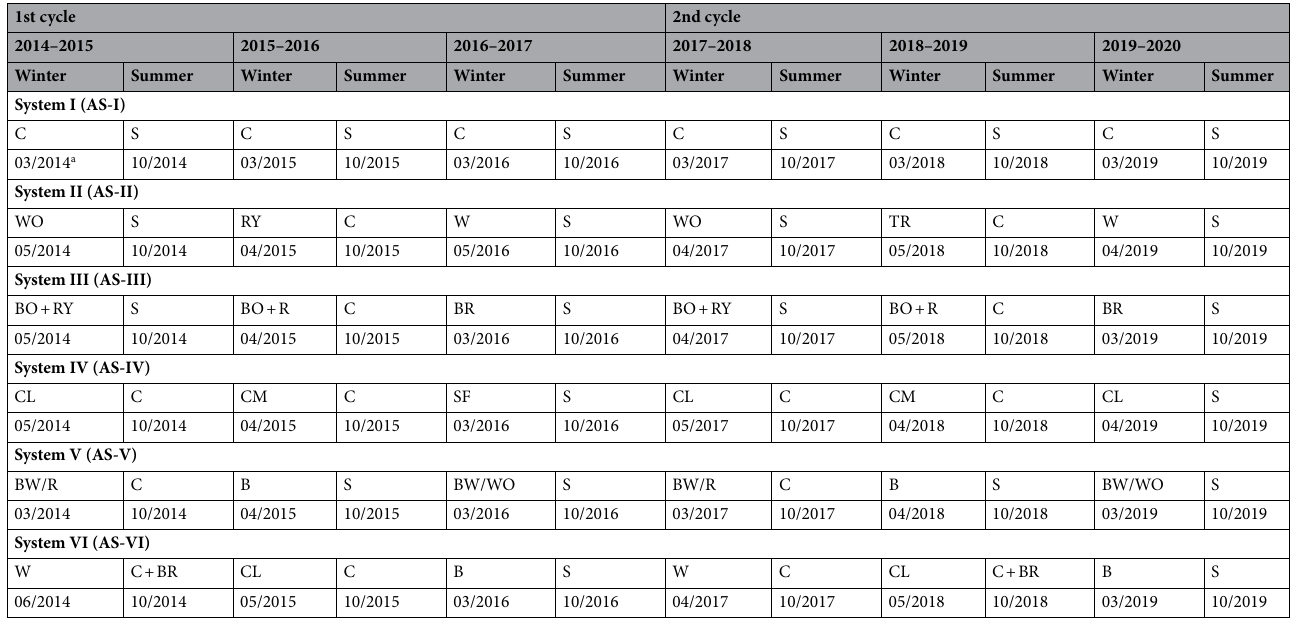
Table 1. Grain production systems and sowing dates in winter and summer in two agricultural cycles, between the crop years 2014–2015 and 2019–2020, in Londrina, state of Paraná, Brazil. WO white oat,